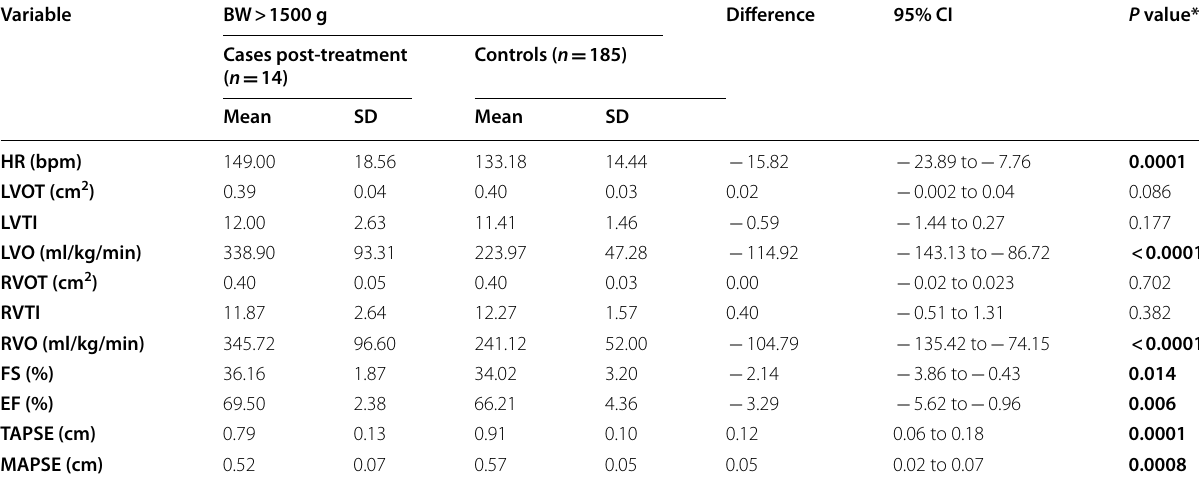
Table 5 Comparison of the echocardiography‑directed management (ECDM) group after treatment and the control group in the cohort of patients with birth weight > 1500 g